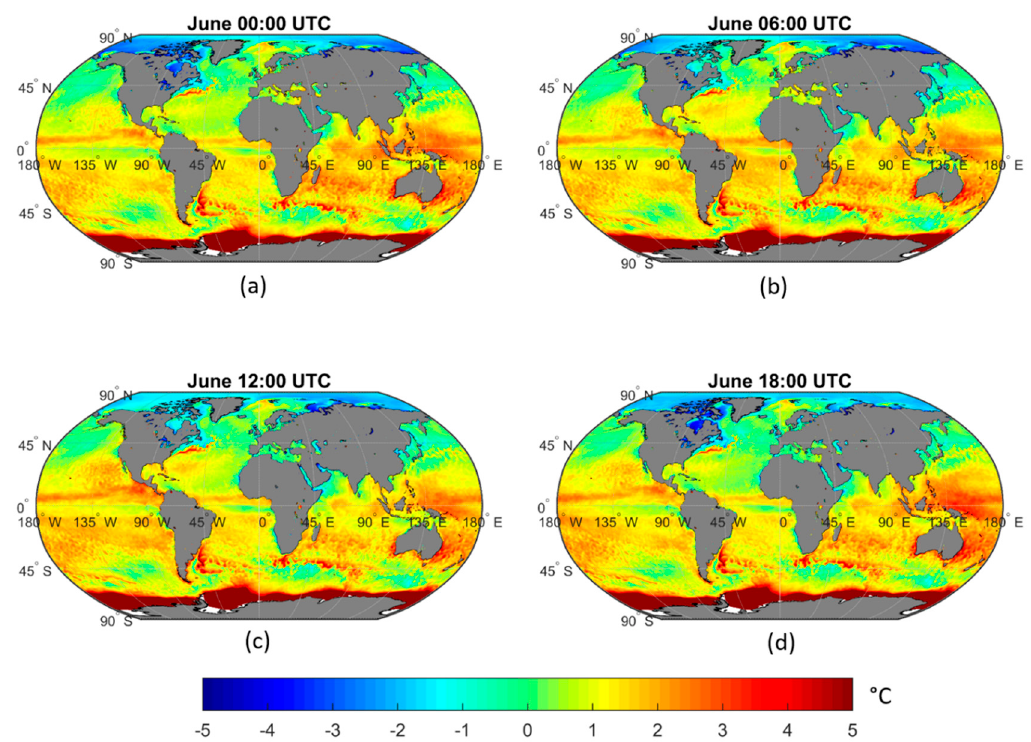
Figure 1. Global maps of the monthly average of sea surface temperature–temperature at 2 m height (SST- t2m ) in the month of June 2018, calculated using ERA5 data [18], for the time steps ( a ) 00:00 UTC; ( b ) 06:00 UTC; ( c ) 12:00 UTC; ( d ) 18:00 UTC.